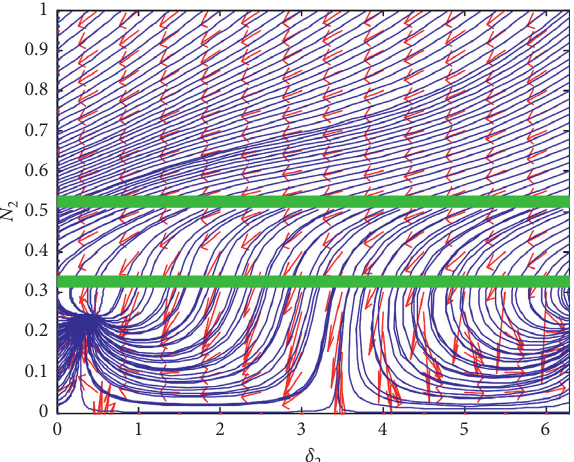
Figure 7: Phase portrait of nonlinear energy sink for the case λ